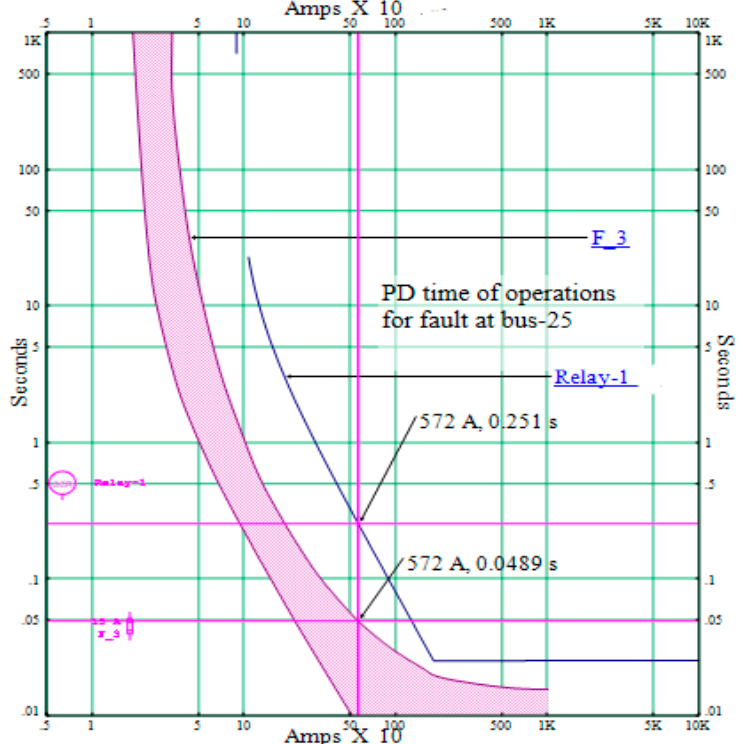
Figure 13. Log–log diagrams of the relay and downstream fuse 3.